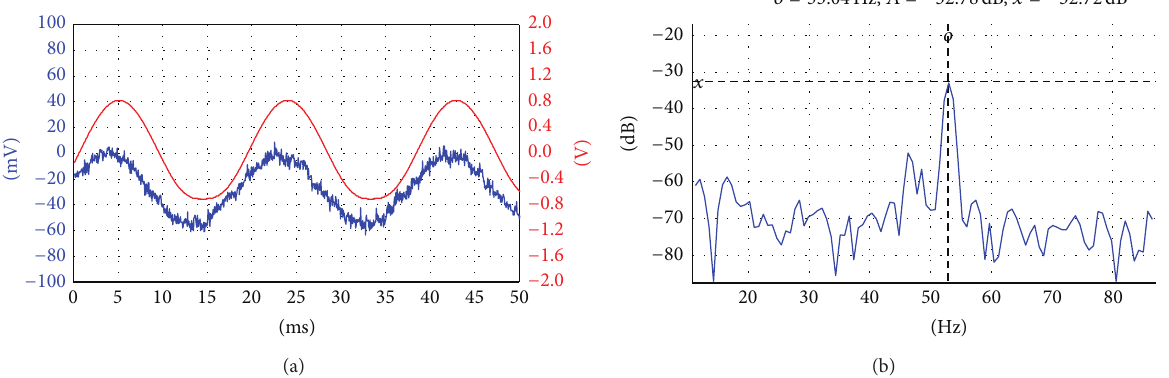
Figure 5: Typical structural acceleration responses: (a) time domain response and (b) spectrum of the time domain response.